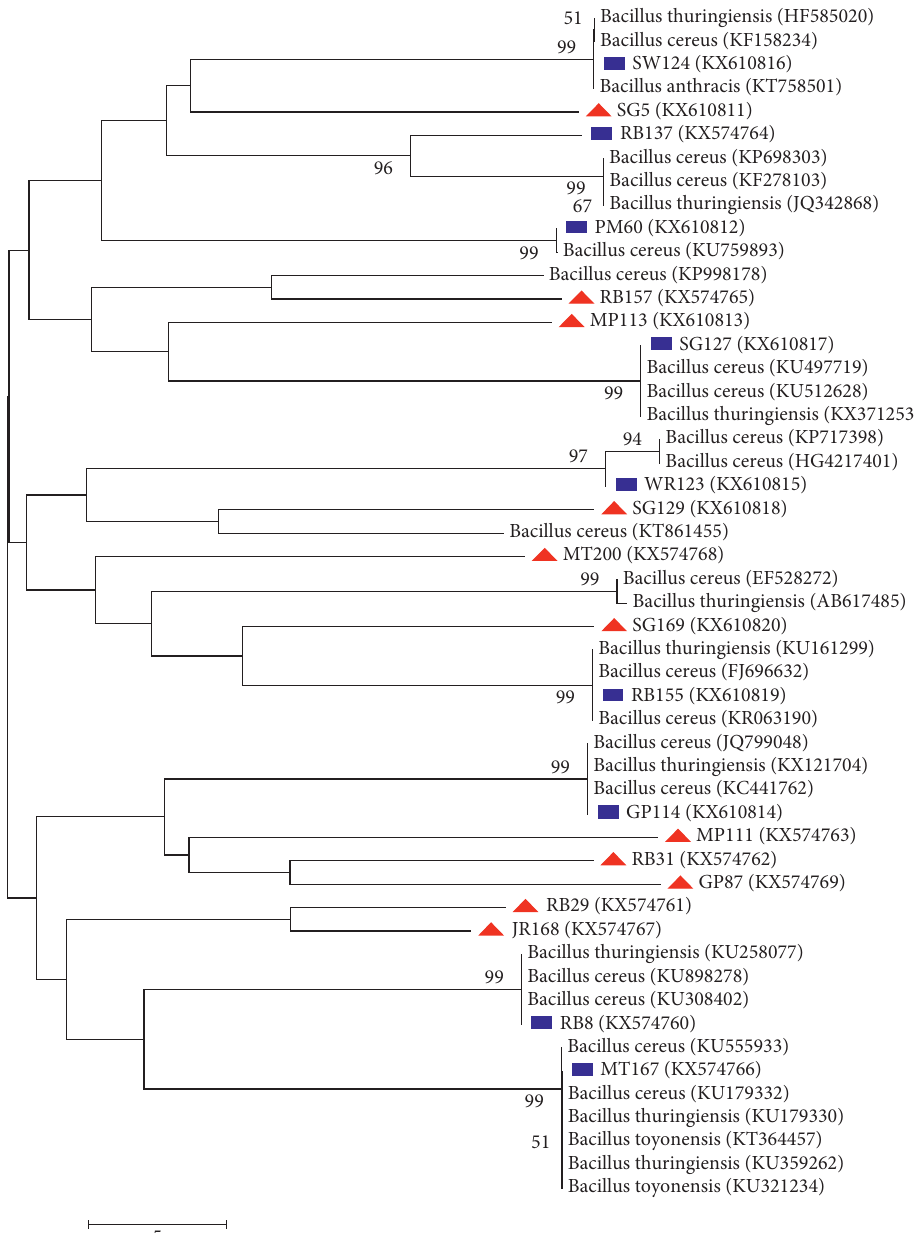
Figure 3: Neighbour-Joining method of phylogenetic tree based on the partial 16S rDNA gene sequence, showing the phylogenetic relationships between the Bacillus cereus and the most closely related strains from the GenBank. Sequences obtained in this study higher than 90% are denoted with rectangle and lower than 50% with a